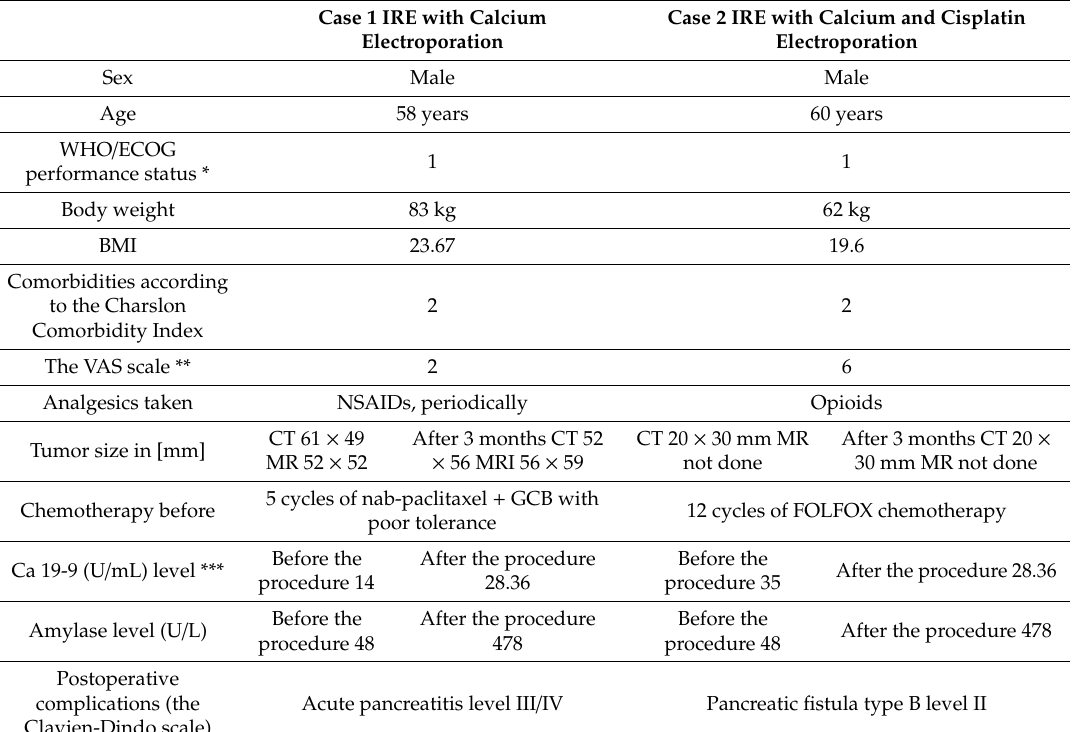
Table 1. Patients’ comparison at the time of qualification for the procedure and immediately after the procedure. VAS: visual analog